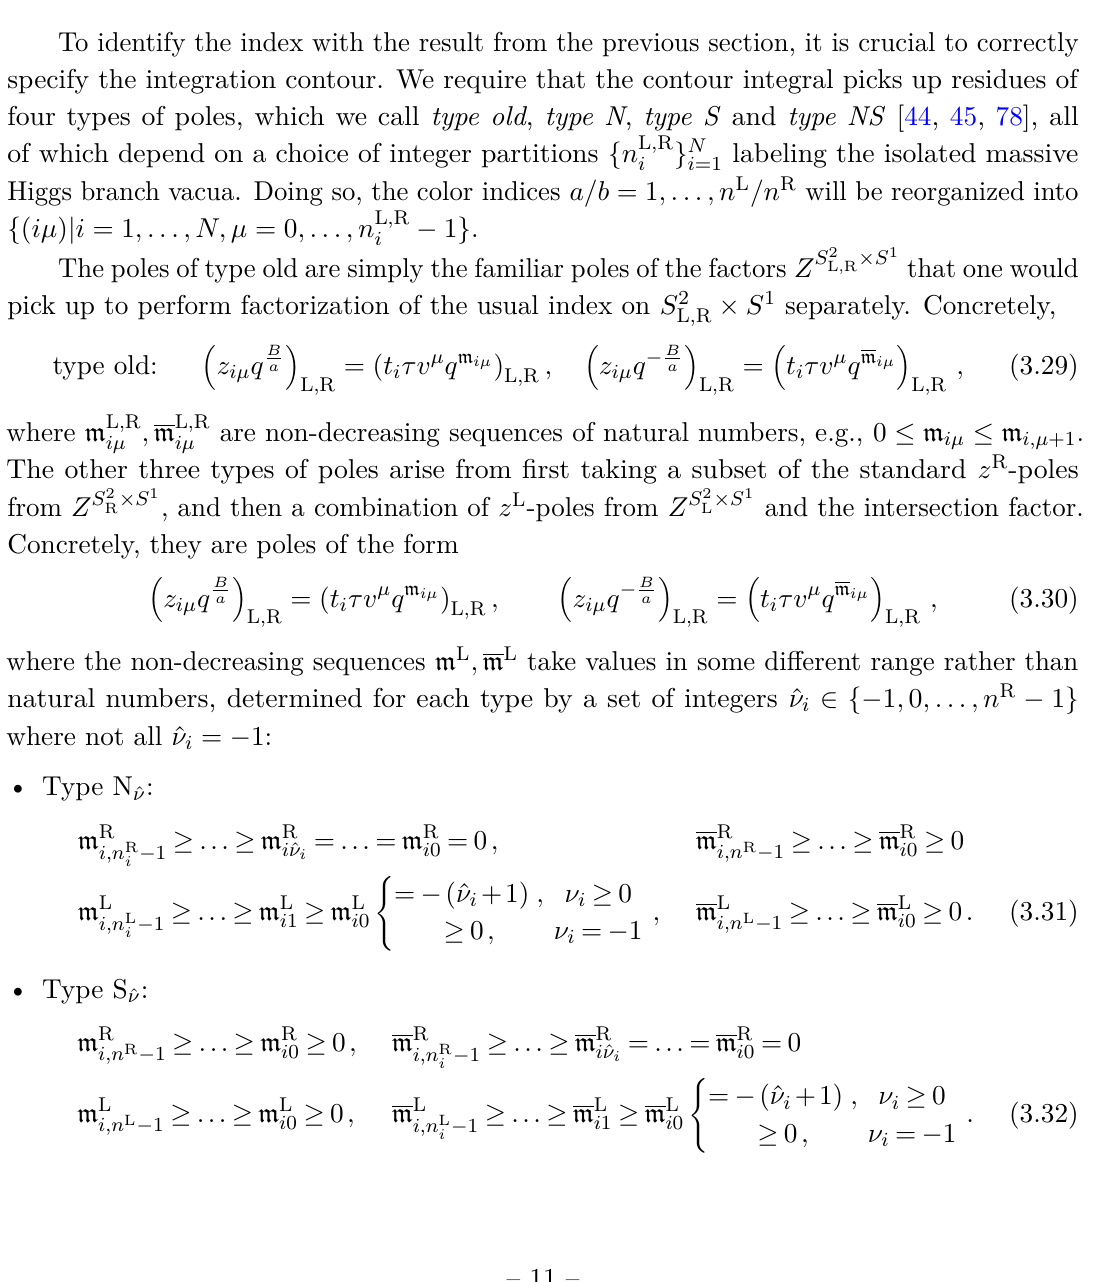
Figure 3 . The worldvolume theory of the surface defect is described by the quiver diagram. Each of the two unitary gauge theories on each S 2 × S 1 is coupled to N fundamental, N anti-fundamental and one adjoint chiral multiplets, and further to the 1d bifundamental chiral multiplet supported on the intersecting, as colored in purple. The red line above indicates the free theory of N 2 hypermultiplets on S 4 × S 1